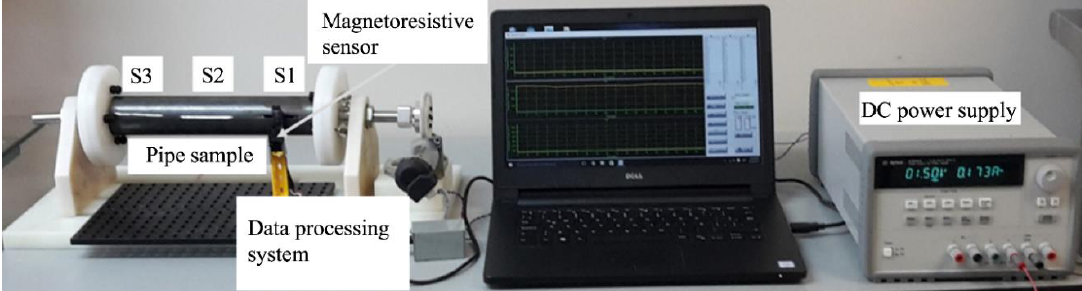
Figure 3. Measurement system of the tangential and normal MMM signals around three rectangular defects of the ASTM A-36 steel pipe.